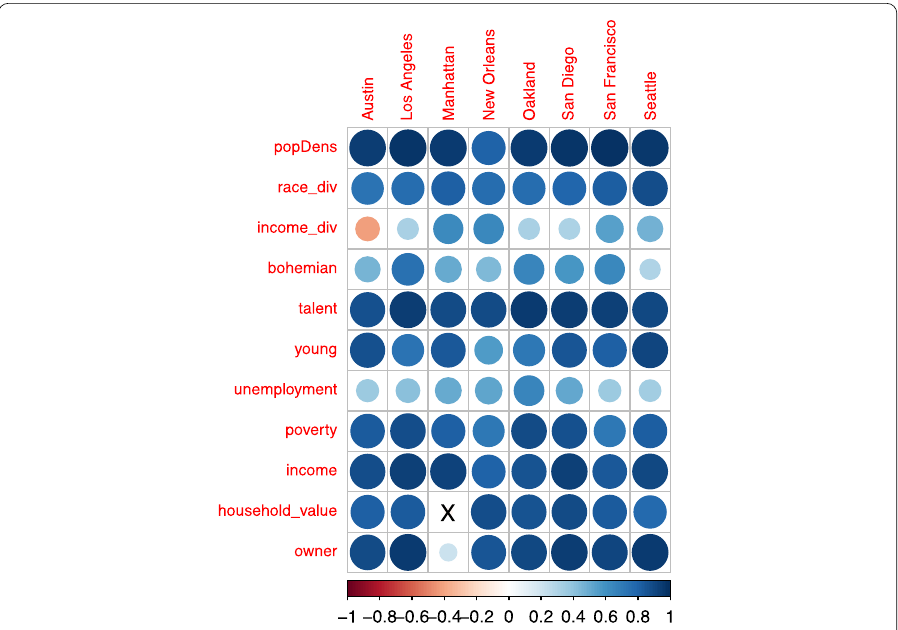
Figure 4 Census 2010 against Census 2000. Spearman correlation between the explanatory variables derived by the U.S. census released in 2000 against the values they assume when the U.S. census released in 2010 is used. Cells marked by “X” denote correlations that are not statistically significant ( p -values greater than or equal to